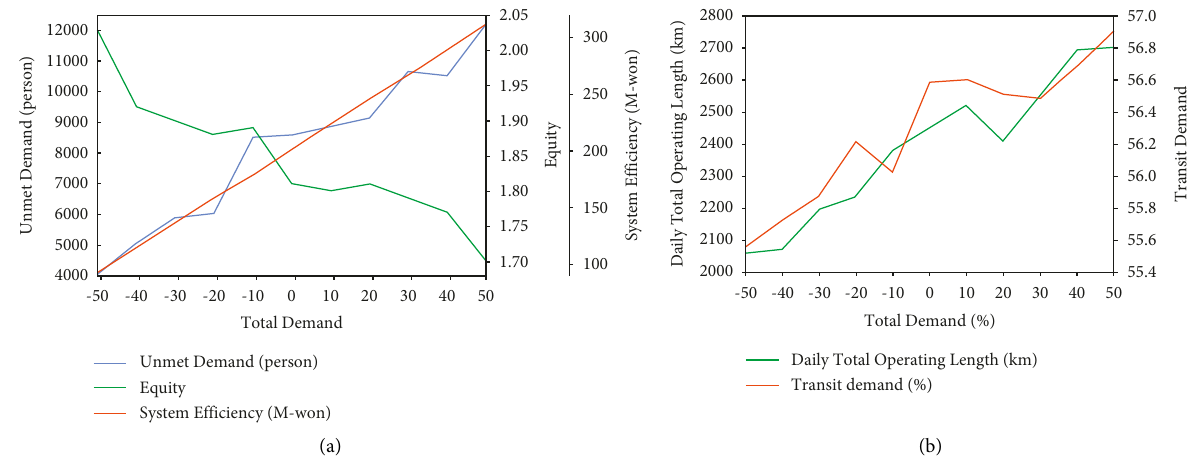
Figure 17: Sensitivity analysis for total demand. (a) The three objective functions. (b) Daily total operating length and transit demand.